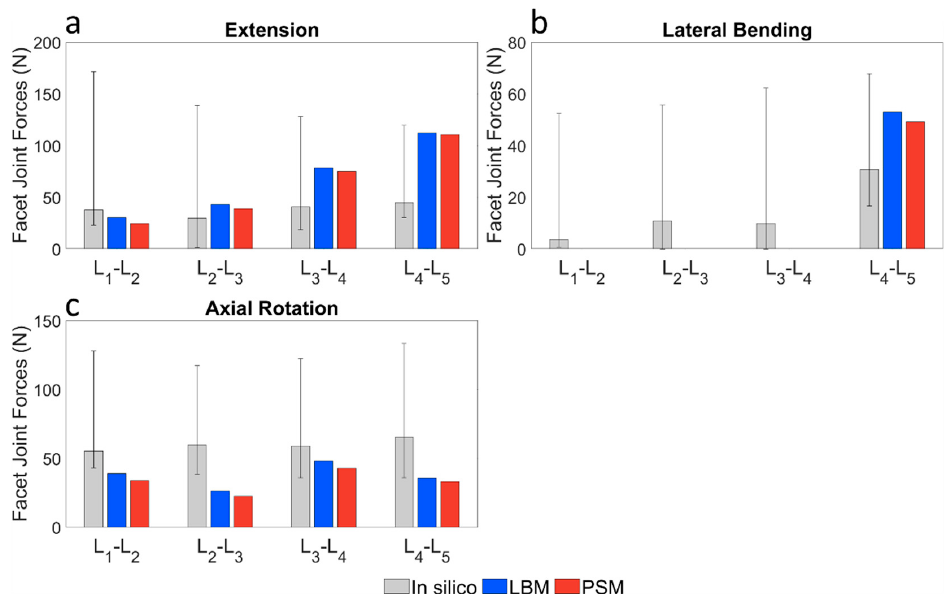
Figure 6. Predicted FJF values at different spinal levels for ( a ) extension, ( b ) lateral bending, and ( c ) axial rotation for the FE models. The grey bars and their range illustrate the median, the minimum, and maximum results of multiple FE models [2].